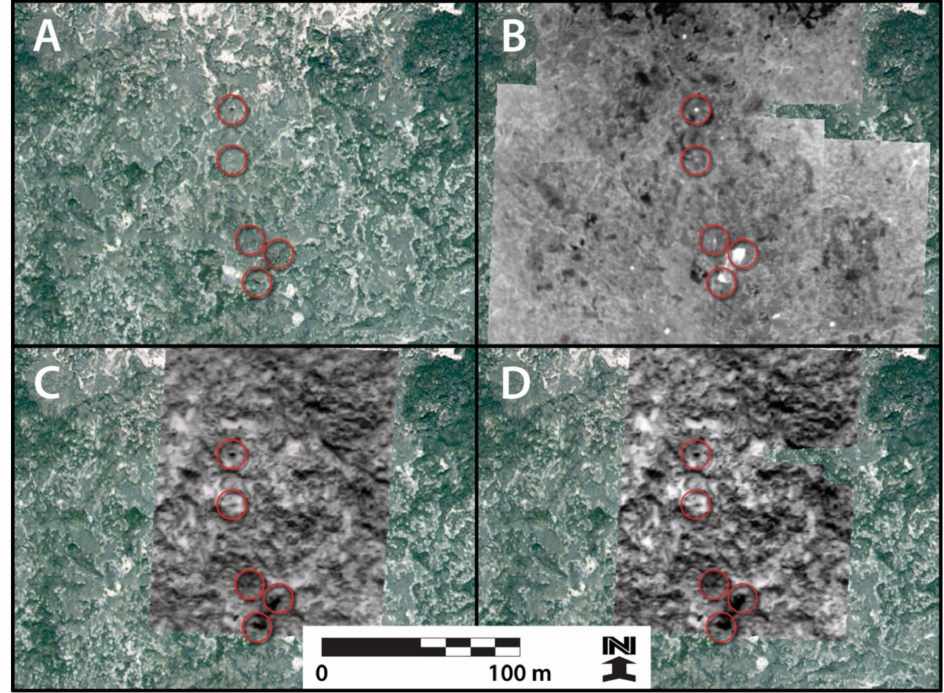
Figure 2. Examples of the different thermal imagery types from Pisgah Lava Field, Mojave Desert, CA, USA with ( A ) cave locations delineated with red circles for ( B ) predawn, ( C ) midday, and ( D ) difference layers (predawn pixel values subtracted from midday pixel values). Thermal values are in hues of gray, with darker hues corresponding to cooler areas and lighter shades to warmer areas. The same general area with caves is depicted within each panel. Scale bar and north arrow, all